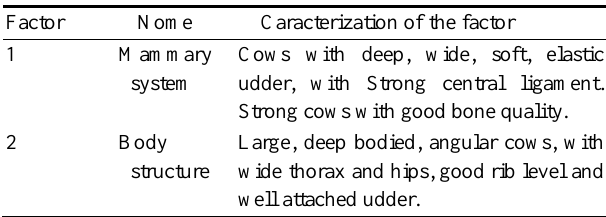
Table 5. Extracted factors and their respective descriptions obtained from linear type traits in Brazilian Holstein cows